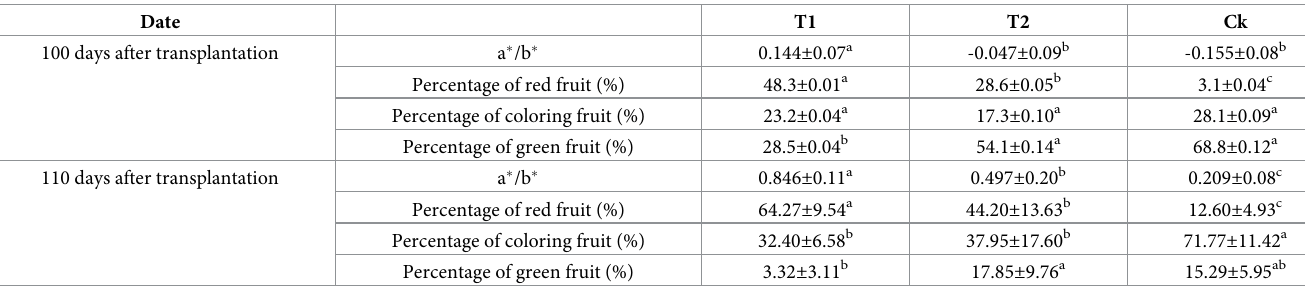
Table 5. Effects of supplemental light on color change and maturity of tomato fruits.